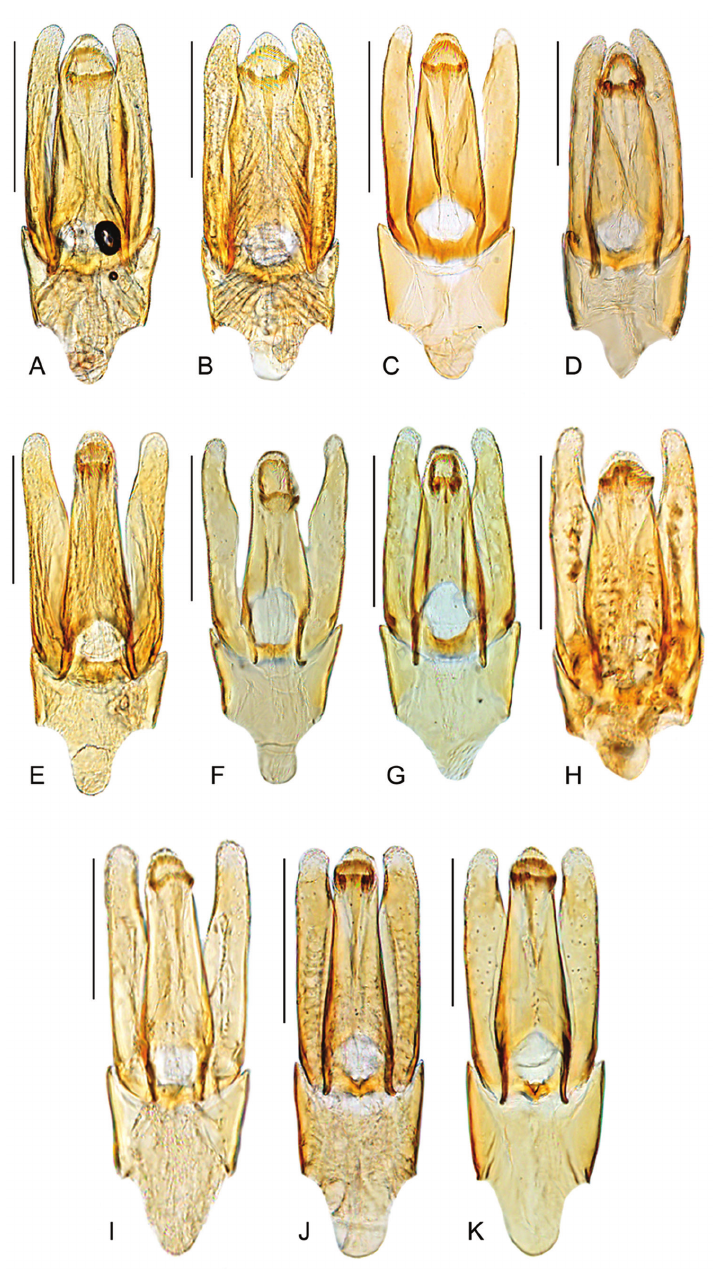
Figure 7. Aedeagus of Quadriops spp.: Q. depressus : A holotype B ‘ politus ’ holotype C ‘ amazonensis ’ holo- type D VENEZUELA: Amazonas: Cerro de la Neblina; Q. reticulatus : E holotype F PANAMA: Chiriquí G COSTA RICA: Puntarenas [CR1ABF00 059] H COSTA RICA, Heredia [CR-11TN/16/016]; Q. clu- sia I BRAZIL: Manaus J GUYANA, Upper Potaro [GY14-0312-04A] K GUYANA, Ayanganna Airstrip [GY14-0317-01B]. Scale bar 0.1